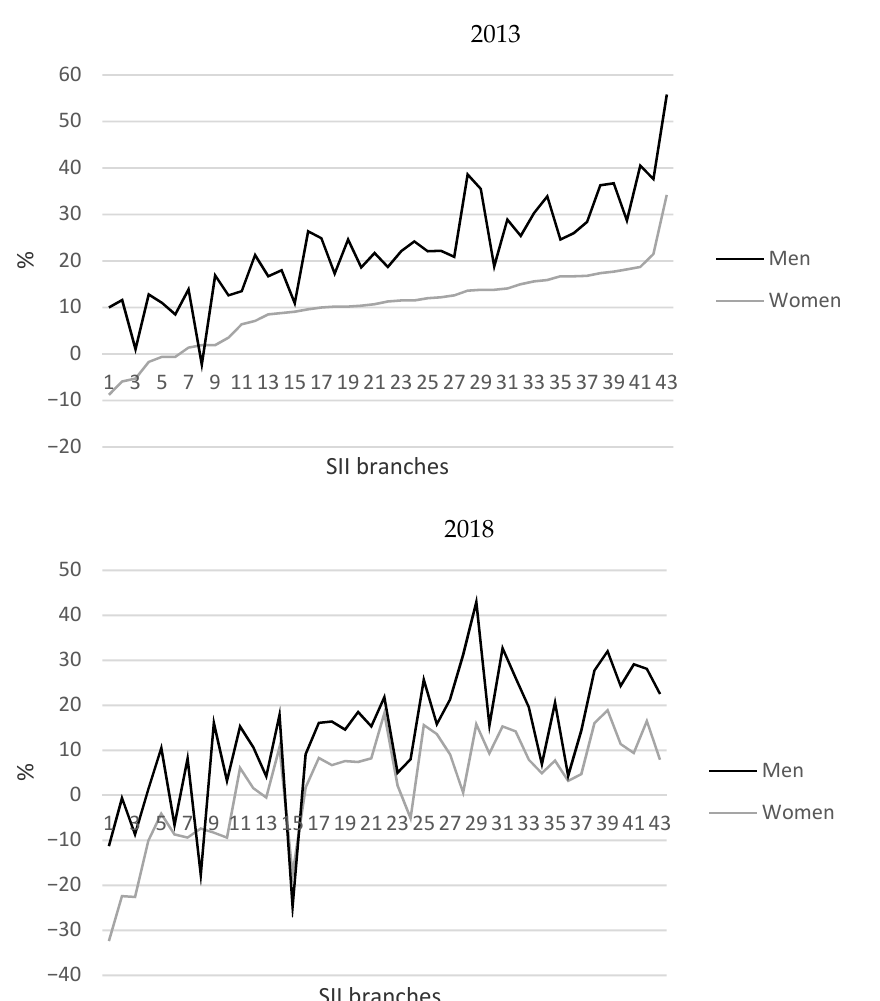
Figure 2. Income and life expectancy ratio in 43 SII branches (in %). Source: authors’ own study.